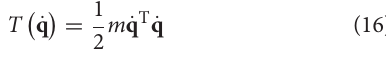
set for GMM registration. Therefore, this model contains